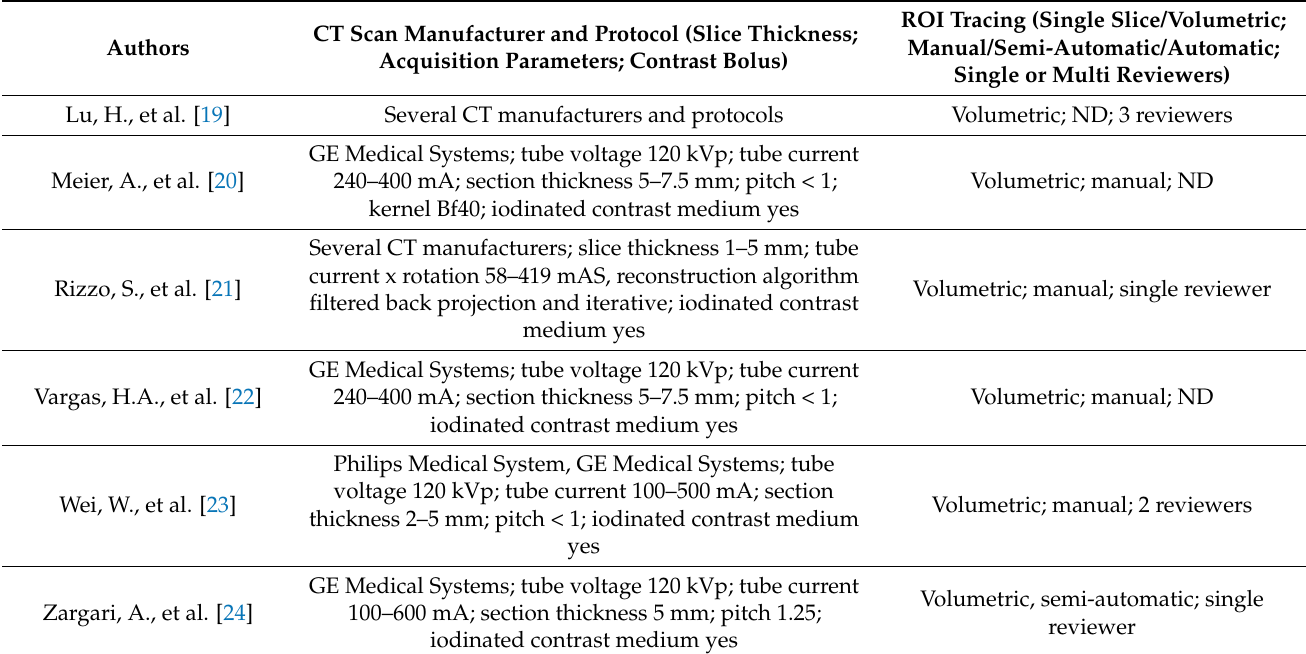
Table 3. Technical Details About CT Acquisition and ROI Tracing of the Included Studies.